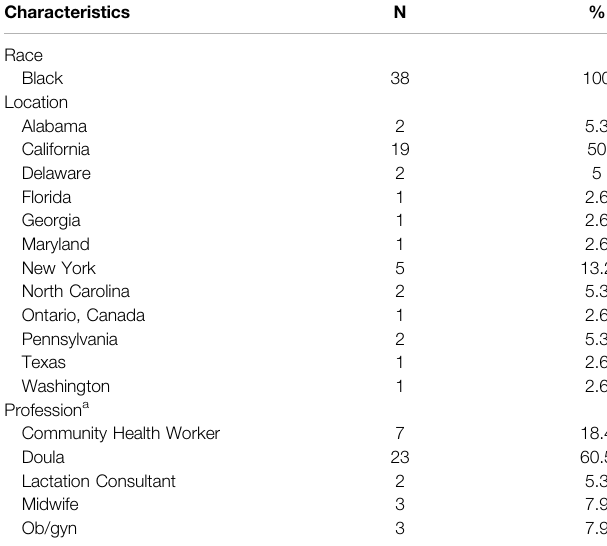
TABLE 1 | Sharing circle